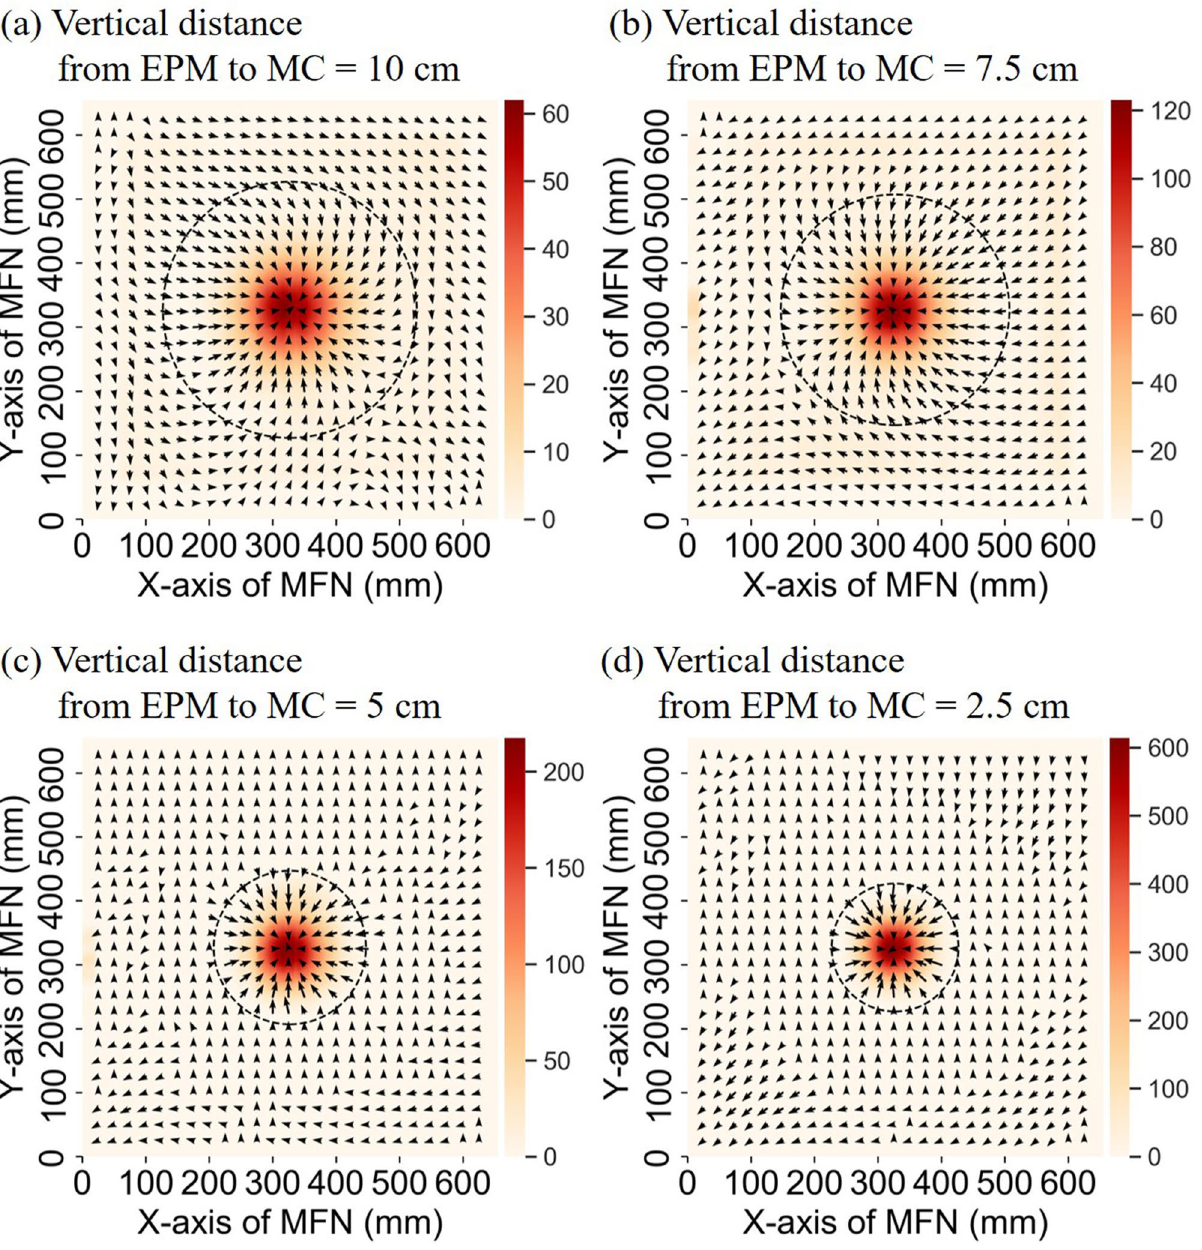
Figure 7. Results of detectable range, force distribution and attractive force when the MC is placed in the center of the MFN platform in four different vertical distance from EPM to MC: ( a ) 10 cm; ( b ) 7.5 cm; ( c ) 5 cm; ( d ) 2.5